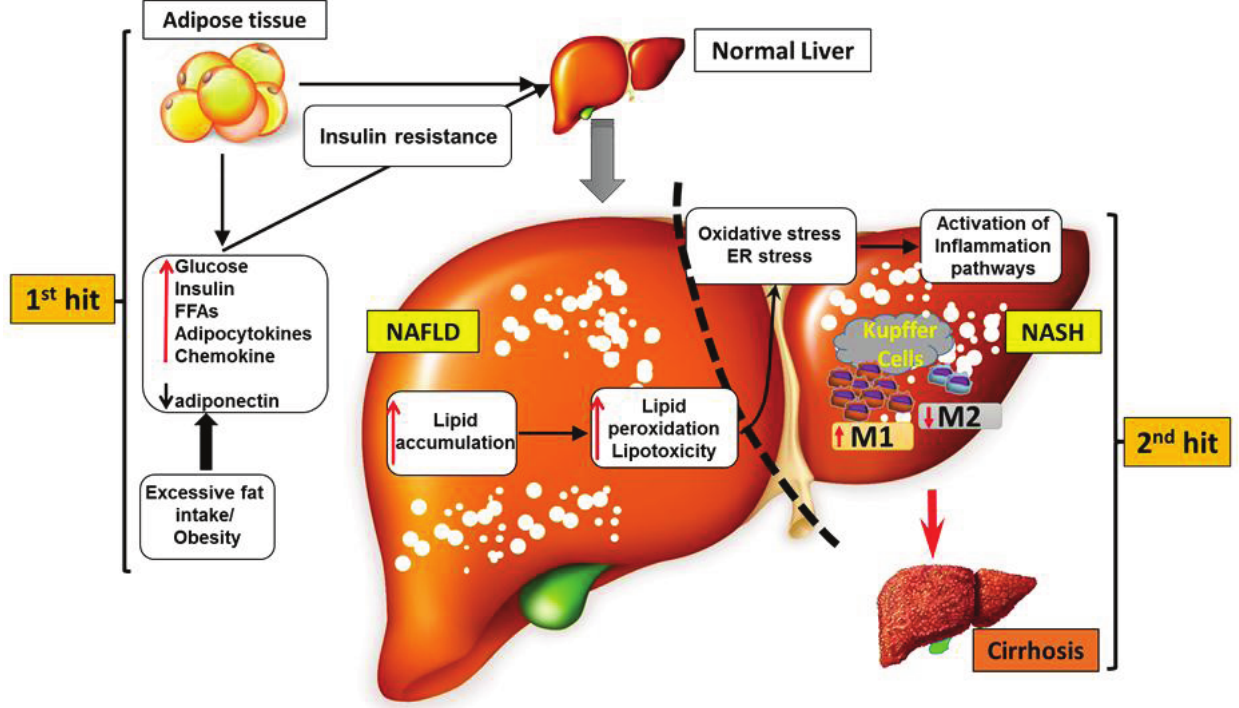
Figure 2. Pathomechanisms during the progression to NASH. The development of NASH is initiated by several different risk factors including a high-fat diet, physical inactivity, and genetic predispositions that often lead to obesity and insulin resistance. Exaggerated fat intake and obesity lead to hyperglycemia, hyperlipidemia, and the over expressions of adipocytokines and chemokines and further contribute to insulin resistance in adipose tissue and the liver. Insulin resistance results in hepatic triglyceride (TG) synthesis and the increased delivery of free fatty acids (FFAs) to the liver. Additionally, hepatic steatosis acts as a “ first hit ” that is followed by a “ second hit ” in which inflammatory mediators can cause NASH and even cirrhosis. An enhanced storage of TG provokes a series of harmful consequences related to hepatocytes, such as uncontrolled lipid peroxidation, oxidative stress, and endoplasmic reticulum (ER) stress, which can activate hepatic inflammatory pathways. In particular, the recruitment of macrophage/Kupffer cells and an M1-dominant phenotypic shift in macrophages in the liver play a key role in the pathological progression of NASH. NASH involves hepatocellular steatosis in conjunction with liver inflammation and hepatocyte lesions.